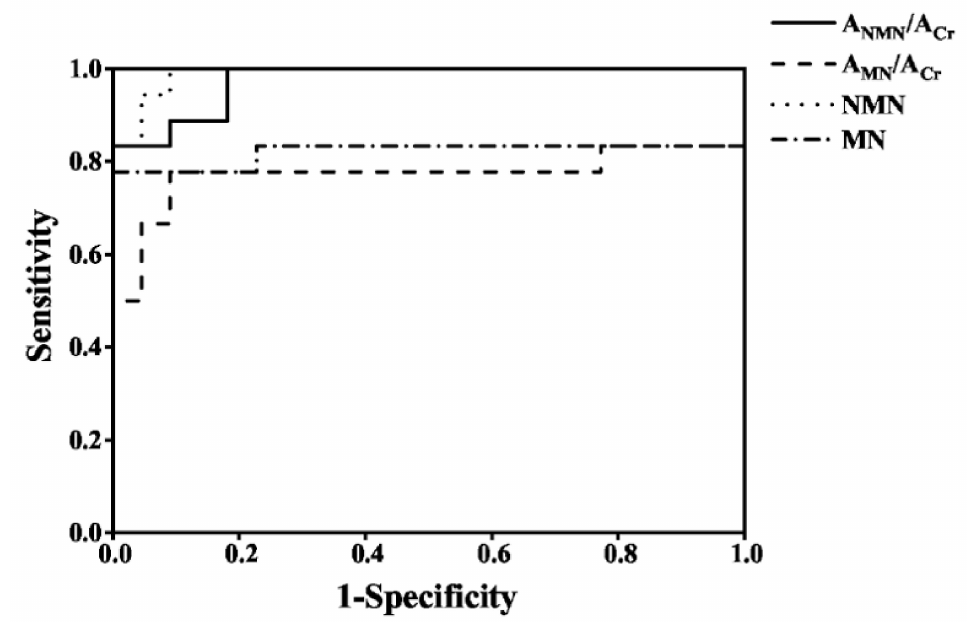
Figure 6. The operator characteristic curves of spot urine A MNs /A Cr and plasma free MNs for the diagnosis of